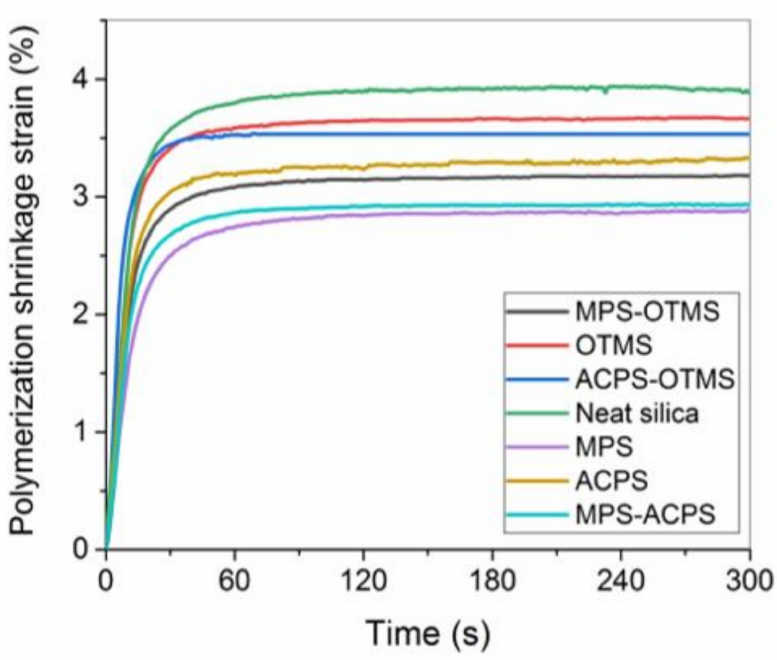
Figure 7. Time dependence of polymerization shrinkage strain of the synthesized dental nanocom- posite resins containing 60 wt% of diverse types of untreated and organically modified